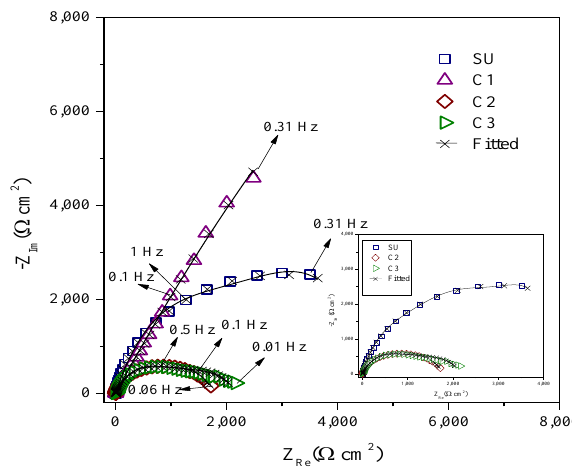
Figure 3. Nyquist diagram of substrate Inconel 718 and C1, C2 and C3 coatings exposed to 2 wt.% H 2 SO 4 solution.